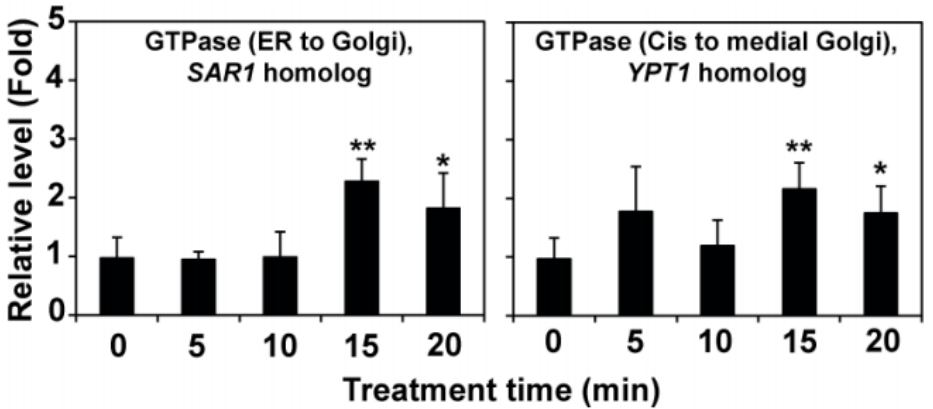
Figure 7. The mRNA levels of two putative genes involved in vesicle trafficking and transport in fungal hyphae cultured for 48 h post plasma treatment of the spores. Each value is indicated as the mean and standard deviation of 6 replicate measurements. ** p < 0.01 and * p < 0.05. Compared to the control DNA (no plasma treatment), the genomic DNA from the plasma-treated samples (5 min and 20 min treatments) displayed approximately 0.0016– 1.0017% variations in sequence (single base pair changes, deletions, and insertions) (Table 2 and Supplementary Tables S1 and S2). No dramatic differences in sequence were observed between the samples treated with plasma for 5 min and 20 min, although a slightly higher mutation rate was exhibited in the samples treated for 5 min (0.0017%) than in those treated for 20 min (0.0016%) (Table 2). The total mutation percentage in the exon area was about 0.0001–0.0002% in the samples treated with plasma for 5 min and 20 min, which was lower than that in the intron area (Table 2). Missense mutations (changes in the amino acid sequence of a gene) occurred at approximately 0.00004–0.0001% positions in 17 and 10 genes upon plasma treatment for 5 min and 20 min, respectively (Table 2 and Supplementary Table S3). Table 2. Total mutations in the genomic DNA of A. oryzae after treatment with plasma for 5 min and 20 min. Treatment Time (min) Mutation Position Number Total